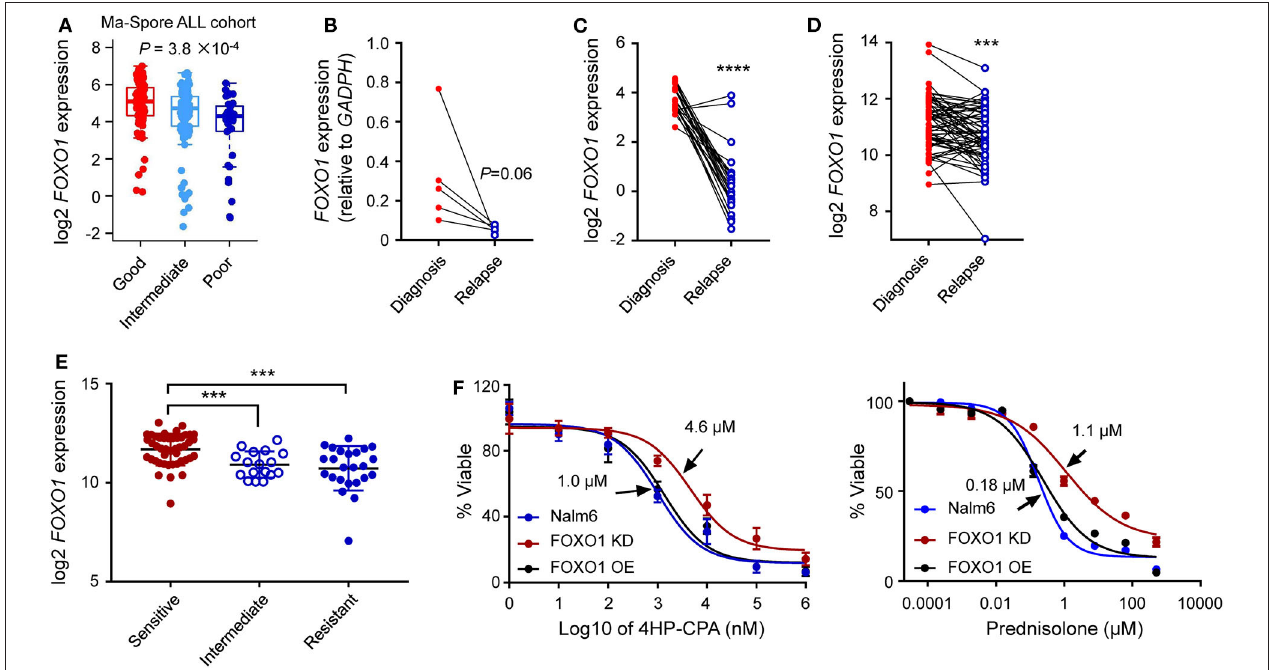
FIGURE 4 | Lower FOXO1 transcription correlated with ALL relapse. (A) Lower FOXO1 was associated with MRD positivity at the end of induction. MRD at the end of induction therapy Day 33 was used: patients with MRD < 0.01% or > 1% were classified as “good” or “poor,” respectively, and others were classified as “intermediate.” (B,C) Lower FOXO1 expression was found in relapsed B-ALL as compared with primary samples in our institutional data (B) and PCGP data (C) . (D) The FOXO1 transcription was extremely low in relapsed B-ALL among the diagnosis-relapse matched paired samples. (E) Lower FOXO1 expression was associated with glucocorticosteroids resistance. (F) Cytotoxicity of prednisone and 4HP-CPA was examined in Nalm6 cells with FOXO1 knockdown (dark red line, FOXO1 KD), over-expression (black line, FOXO1 OE), or parental cells (blue line). Cells were incubated with drugs for 72h, and viability was then measured using MTT assay. Experiments were performed in triplicate and repeated at least three times. Statistical significance, determined using two-sided unpaired t -test (A,E) or two-sided paired t -test (B–D) , is indicated by *** P < 0.001 and **** P <